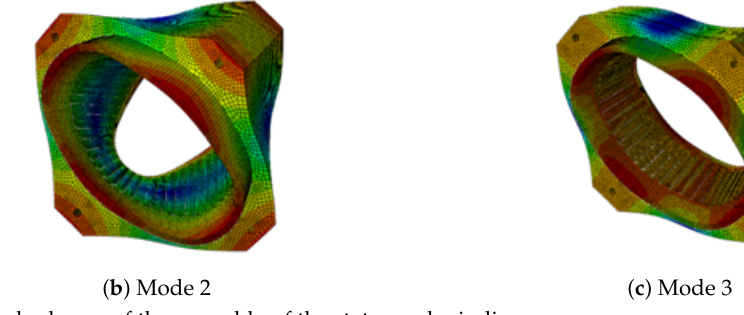
Figure 6. First three mode shapes of the assembly of the stator and windings.